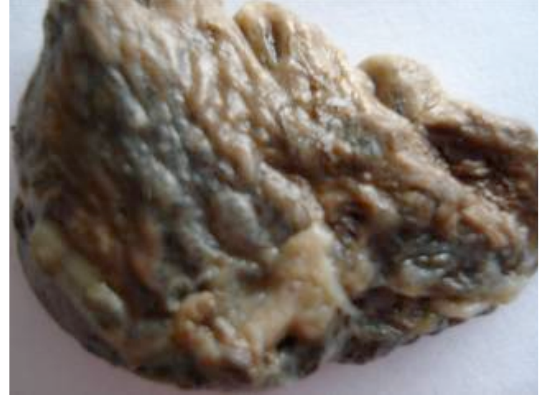
Image 10. Lung of Beisa Oryx showing caseous nodules and black-brown coloration all